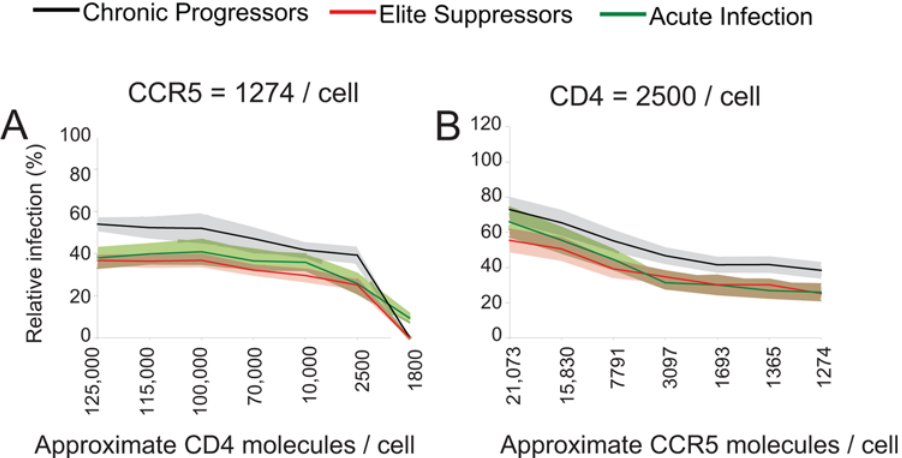
Figure 4. Acute env clones show no significant receptor or co-receptor utilization difference from chronic or elite envs. (A) Affinofile cells were induced to express minimal CCR5 (approximately 1274 molecules/cell) and CD4 molecules ranging from approximately 1,800 to 125,000 molecules/cell or (B) threshold (approximately 2,500) CD4 molecules/cell and CCR5 molecules ranging from approximately 1,274 to 21,073 molecules/ cell prior to infection. Induced Affinofile cells were infected with equivalent amounts of pseudotyped viruses. Average of all acute (green), chronic (black), and elite (red) clones are shown. 95% confidence intervals are given for acute (light green), chronic (grey) and ES (pink).